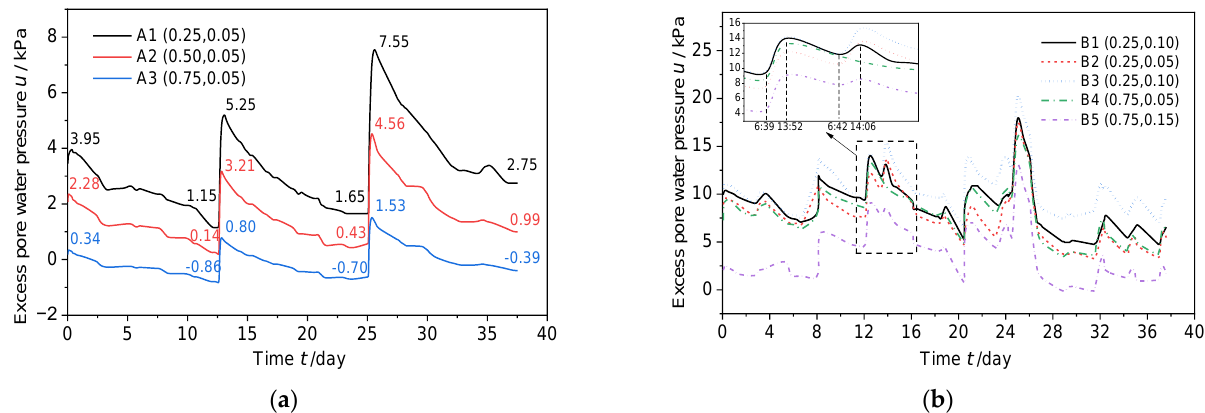
Figure 8. Excess pore water pressure curves with time. ( a ) Ambient temperature group; ( b ) solar heating group.